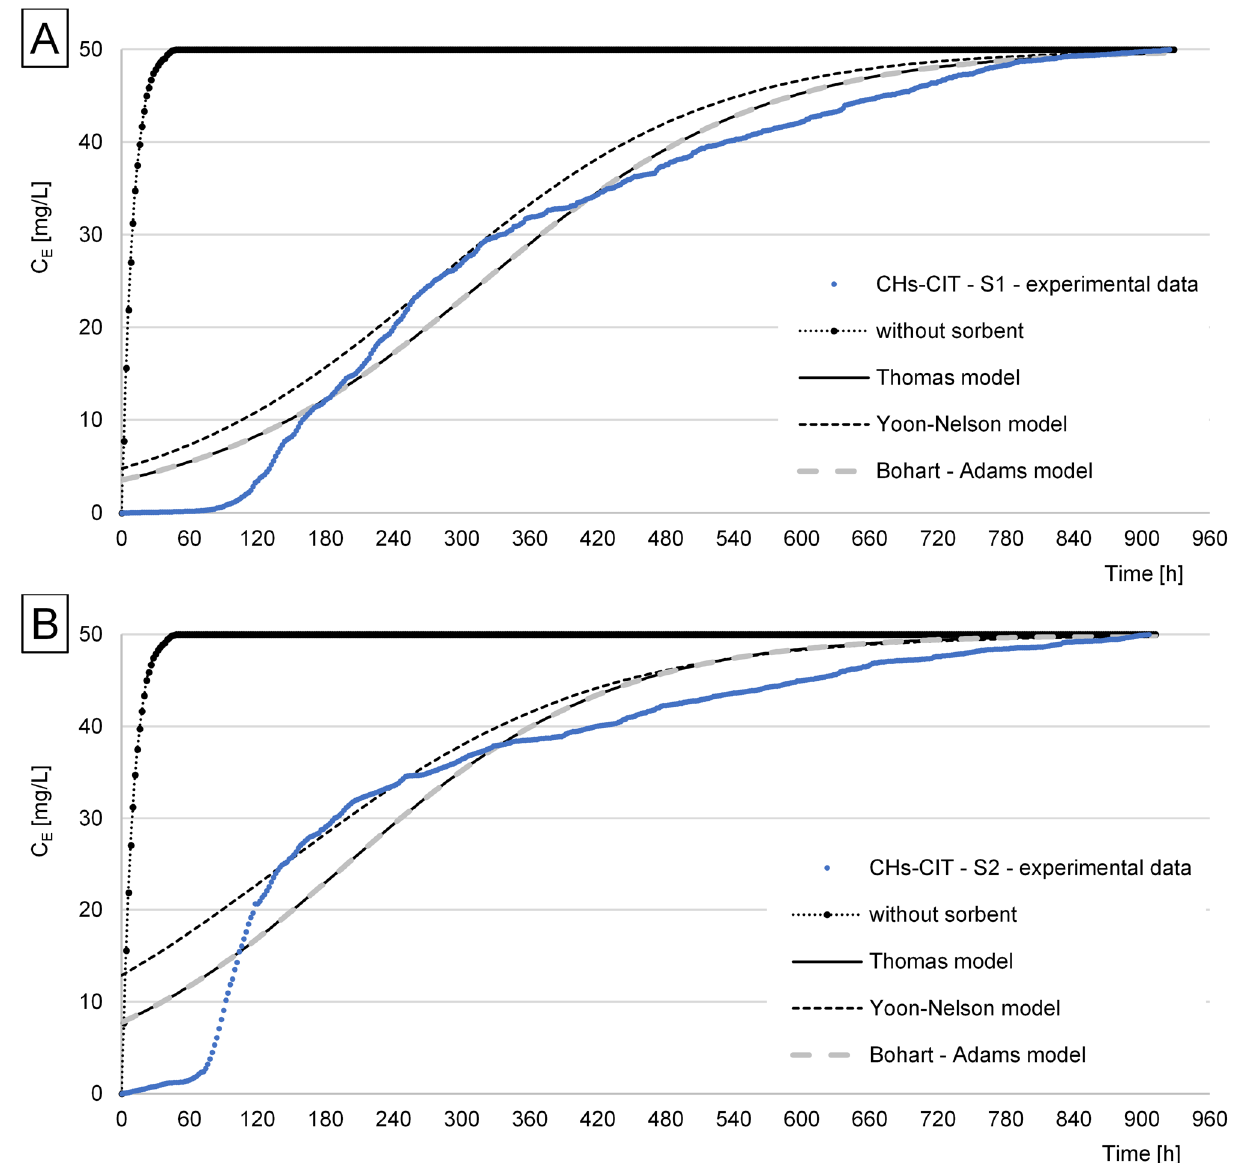
Figure 5. Concentration of RB5 at the outlet from the air-lift with a filling from CHs-CIT: ( A ) S1, ( B ) S2.